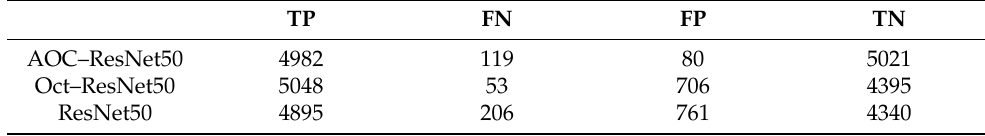
Table 3. Converter fault detection results.